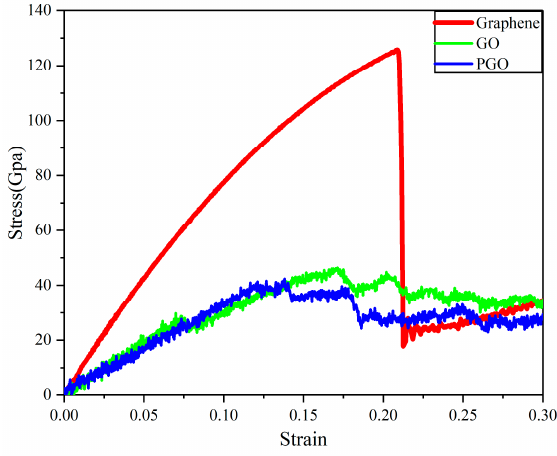
Figure 4. The stress–strain curves under uniaxial tension.